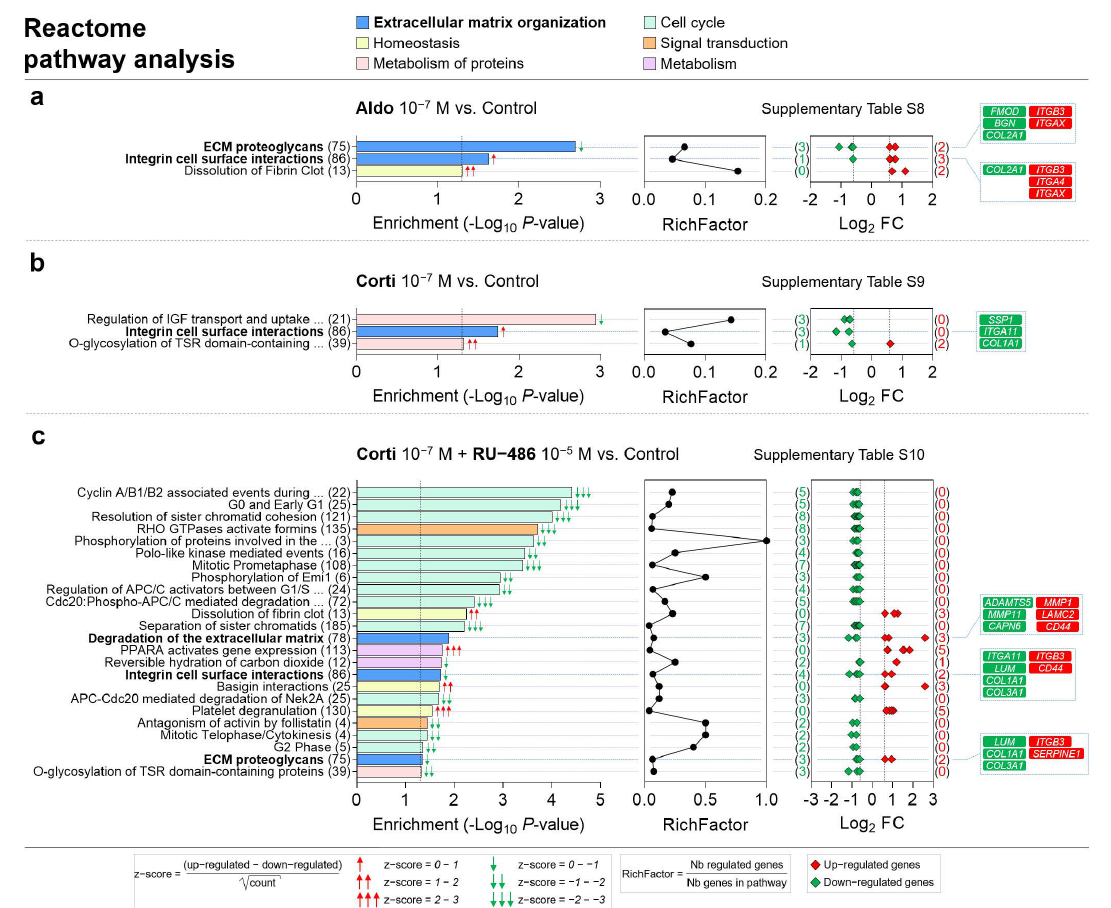
Figure 8. ECM organization, homeostasis, metabolism of proteins, cell cycle, signal transduction and metabolism are the most represented Reactome pathway categories enriched in corticosteroid-treated iRPE cells. ( a – c ) Specific corticosteroid- regulated enriched Reactome pathways as predicted by bioinformatic enrichment analysis with their respective RichFactor value and the number of differentially expressed genes (DEGs) involved in the pathway, in iRPE cells treated for 24 h with aldosterone (aldo) 10 − 7 M ( a ), cortisol (corti) 10 − 7 M ( b ) or cortisol 10 − 7 M + RU-486 10 − 5 M ( c ) and compared to untreated cells. Reactome pathways are considered enriched if p value is <0.05 and the number of regulated genes in the pathways is ≥ 2. p -values, and fold-change (FC) values are represented in a − Log 10 and a Log 2 scale, respectively. Most represented enriched Reactome pathways and pathways of interest are highlighted in bold. Based on z-score values, green and red arrows in the left panel indicate down- and up-regulated pathways, respectively. Numbers between parentheses placed after enriched Reactome pathway names in the left panels represent the total number of genes implicated in the respective pathway. Numbers between parentheses in the right panels indicate the number of down- (in green) and up-regulated (in red) genes in their corresponding pathway. Corticosteroid-regulated genes in Reactome pathways of interest are listed in the right panel (Corti 10 − 7 M + RU-486 10 − 5 M vs.